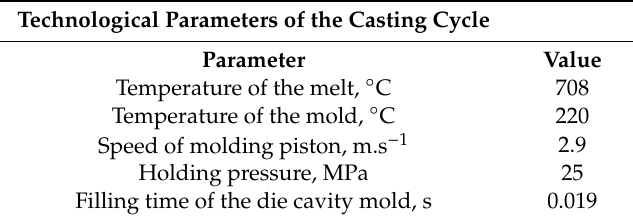
Table 3. Technological parameters of the casting